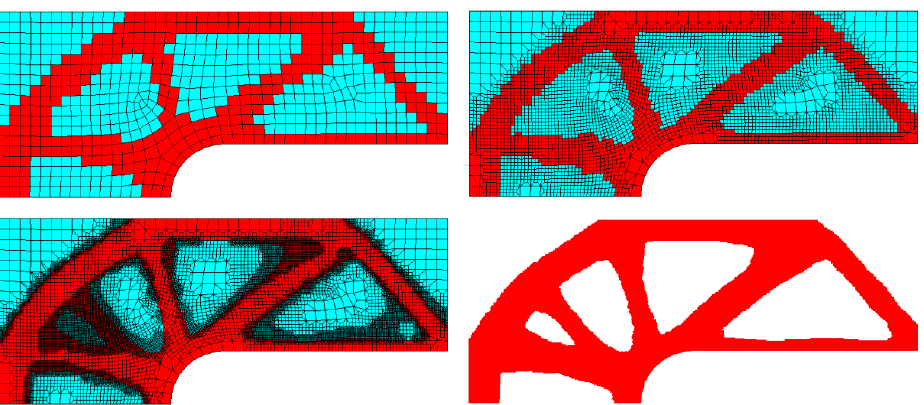
Figure 27. The knee structure, an initial structure with applied loads and supports.